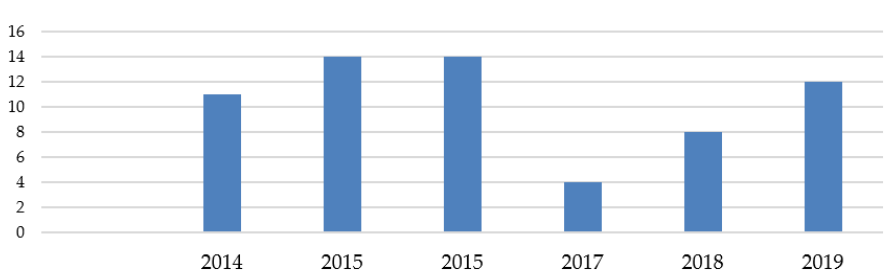
Figure 9. Performance of remedy and prevention by the soil service in years 2014–2019. Source: own representation based on the annual report on the activities of the National Agricultural and Food Centre for the years 2015–2020 [63].